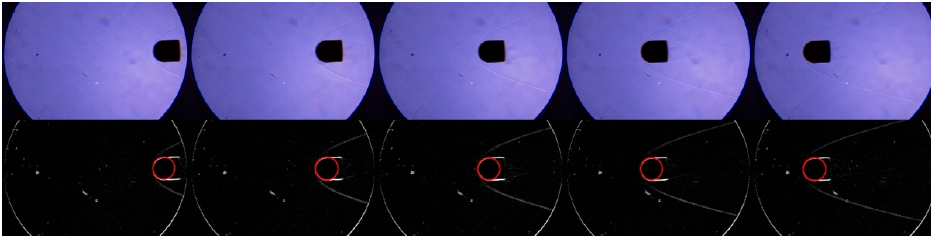
Figure 4. Results of high-speed photography with a time interval of 13.3 µ s; the projectile has a diameter of 30 mm and the velocity is 2481 m / s; the pressure in the target chamber is 5000 Pa. The optical window was 3320 mm away from the muzzle exit.